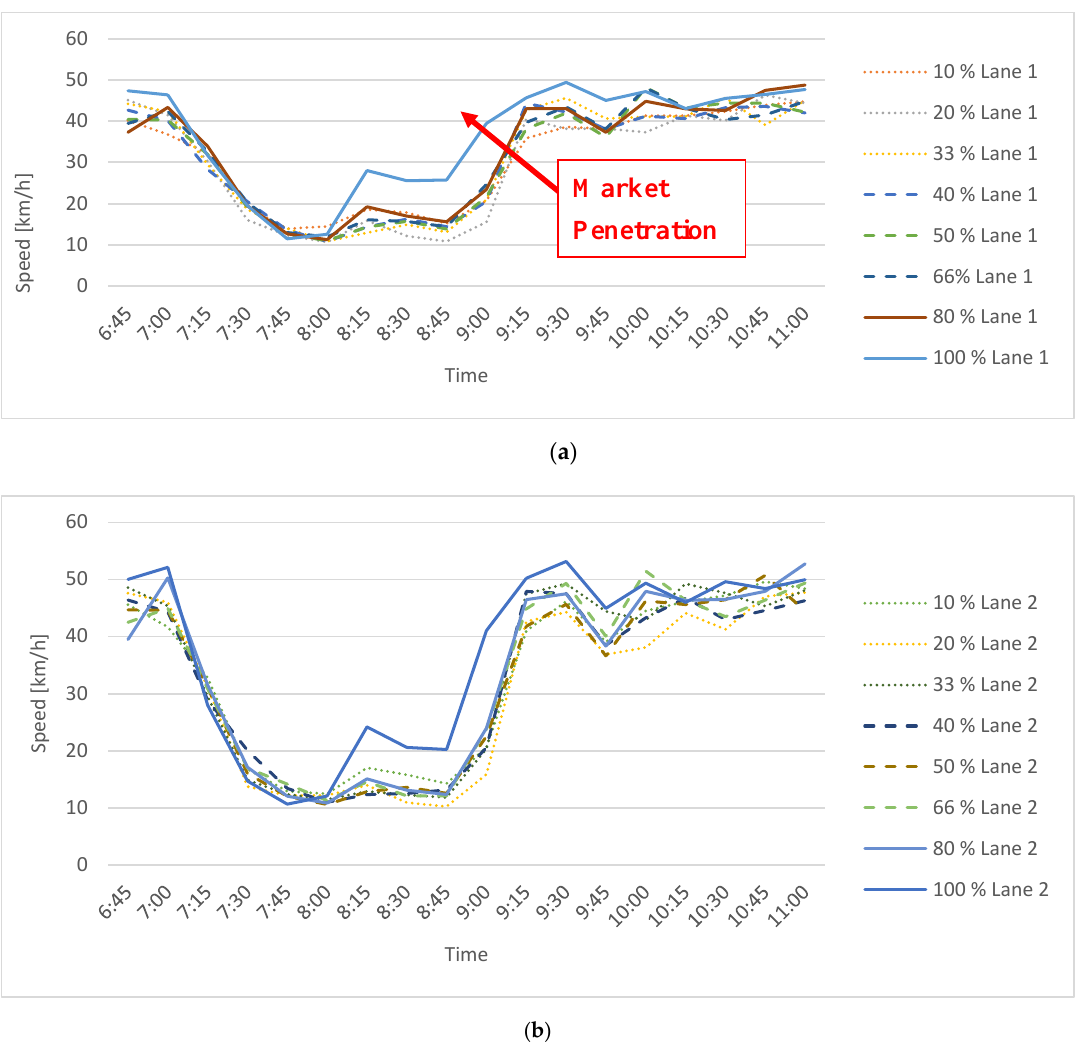
Figure 8. Driving speed 200 m upstream the lane closure: ( a ) slow lane and ( b ) fast lane .